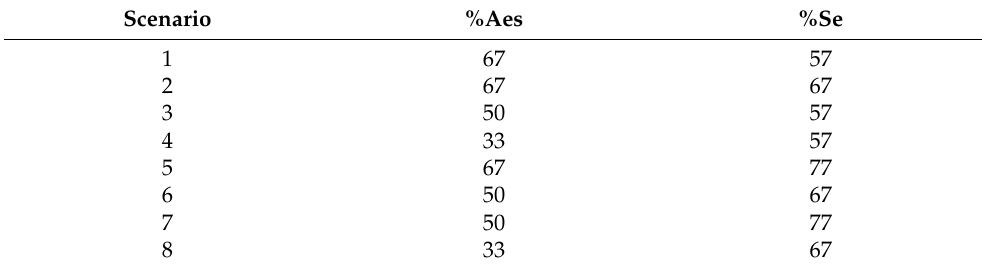
Table 4. Evaluated scenarios.